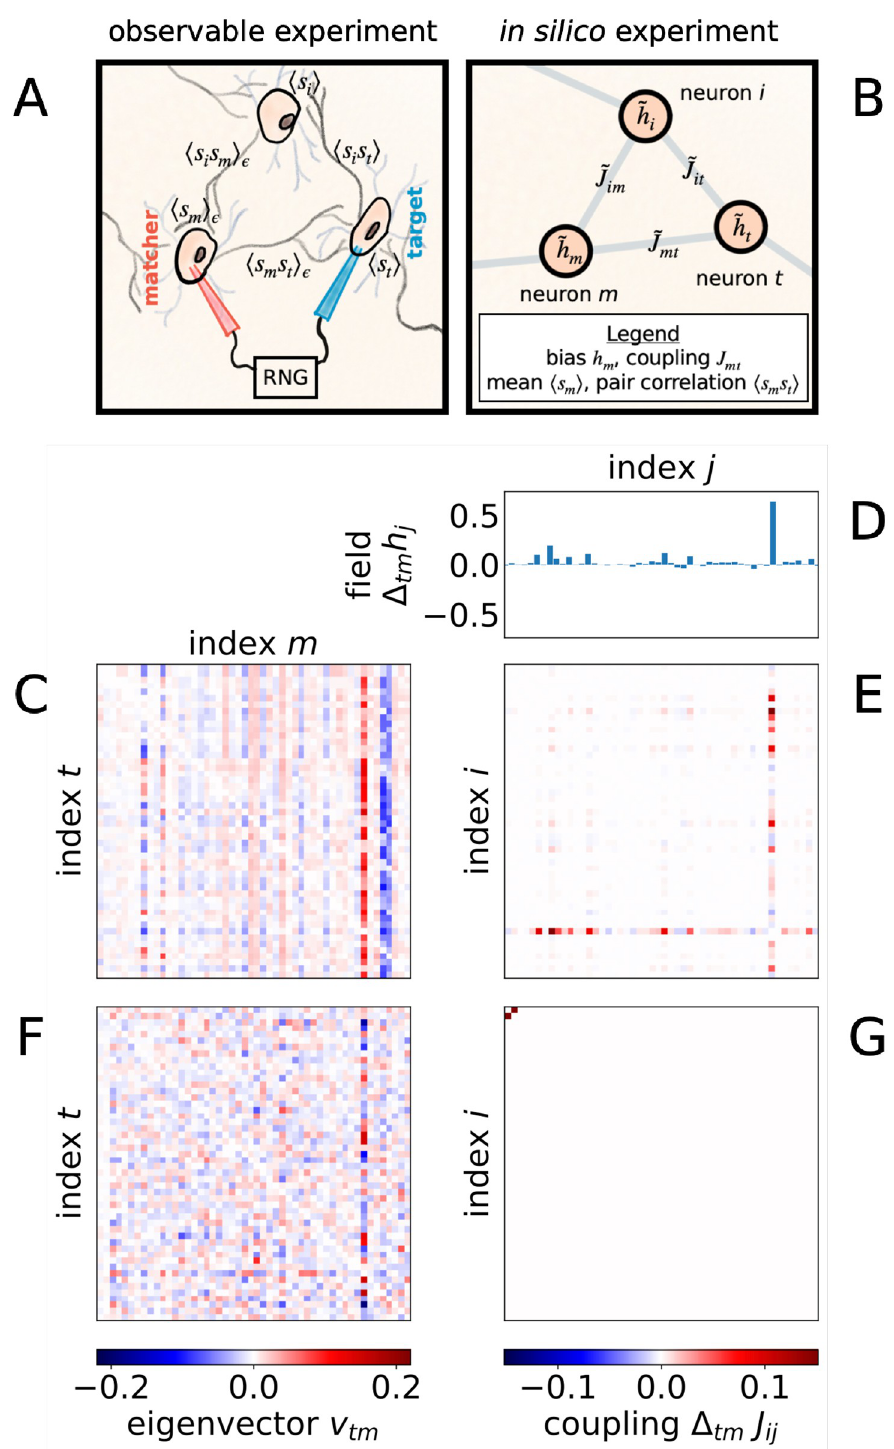
Fig 3. (A) Perturbation thought experiment consists of clamping matcher neuron m to the state of target neuron t with some small probability � when indicated by a random number generator (RNG). We draw electrodes controlling membrane voltage, but optogenetic protocols are more elegant. (B) Perturbation corresponds to modifying fields and couplings in a pairwise maxent model. (C) Principal eigenmatrix for fine-grained synchrony mapped to change in (D) biases { h i }, shown only for the “down” state, and (E) couplings { J ij } for � = 10 − 4 . (F) Diffuse observable perturbation using replacement rule from Eq 4 corresponds to (G) localized “natural” perturbation to one coupling (note nonzero values in the top left